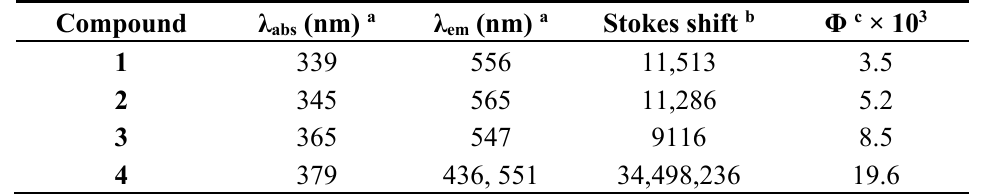
Table 3. Summary of optical absorption and emission properties of 1 – 4 in cyclohexane.